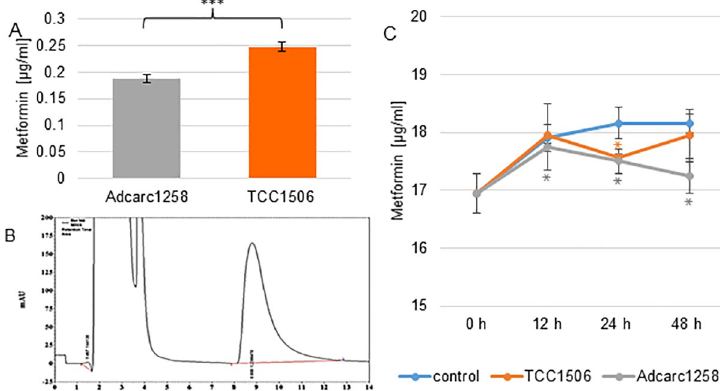
Fig 8. Metformin content in cell pellets of Adcarc1258 and TCC1506 after exposure to 0.1 mM metformin over 48 h (A). Typical chromatogram of metformin 10 μ g/mL in cell culture media (B). Metformin content in cell culture medium supernatant of TCC1506 (orange line) and Adcarc1258 (gray line) in comparison to a control (blue line) incubated with 0.1 mM metformin parallel to the tumor cells without cells (C). Means and standard deviation are displayed, n = 3. Black asterisks: significant difference between Adcarc1258 and TCC1506 (A). Gray asterisks: significant difference between the control and Adcarc1258 (C). Orange asterisks: significant difference between control and TCC1506 (C). Significance is set at p � < 0.05, p �� < 0.01 and p ��� < 0.001,